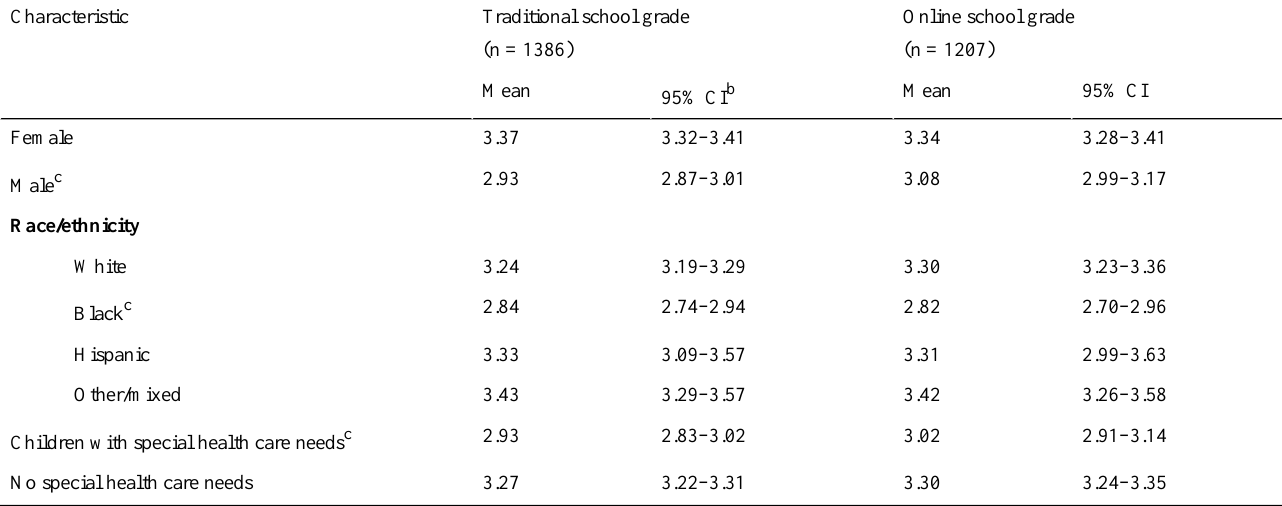
Table 3. Parental report of grades a in traditional and online school by demographic